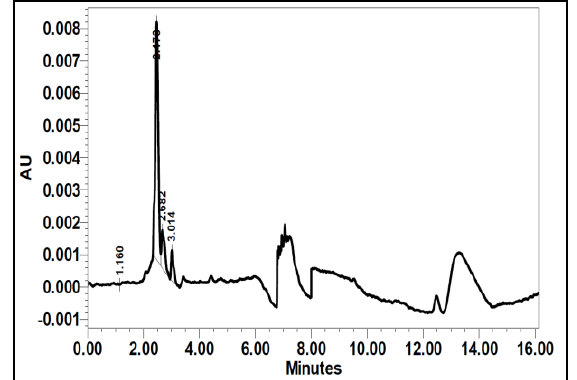
Fig. 8 . HPLC chromatogram of blank saliva at a timed wavelength of 265, 260 & 230